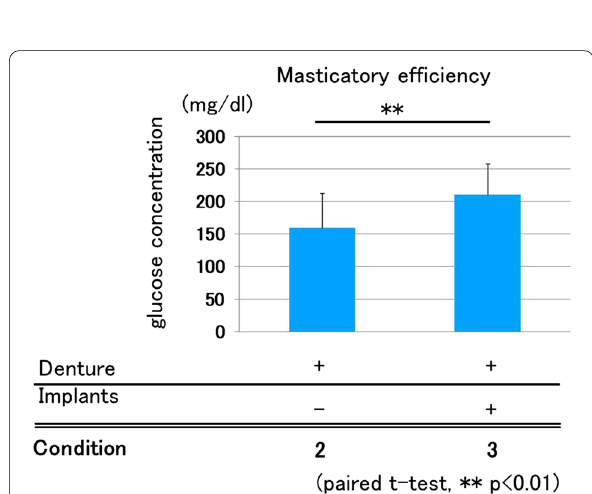
Fig. 6 Masticatory efficiency. Condition 3 showed significantly greater masticatory efficiency compared with Condition 2 (paired t -test, p <